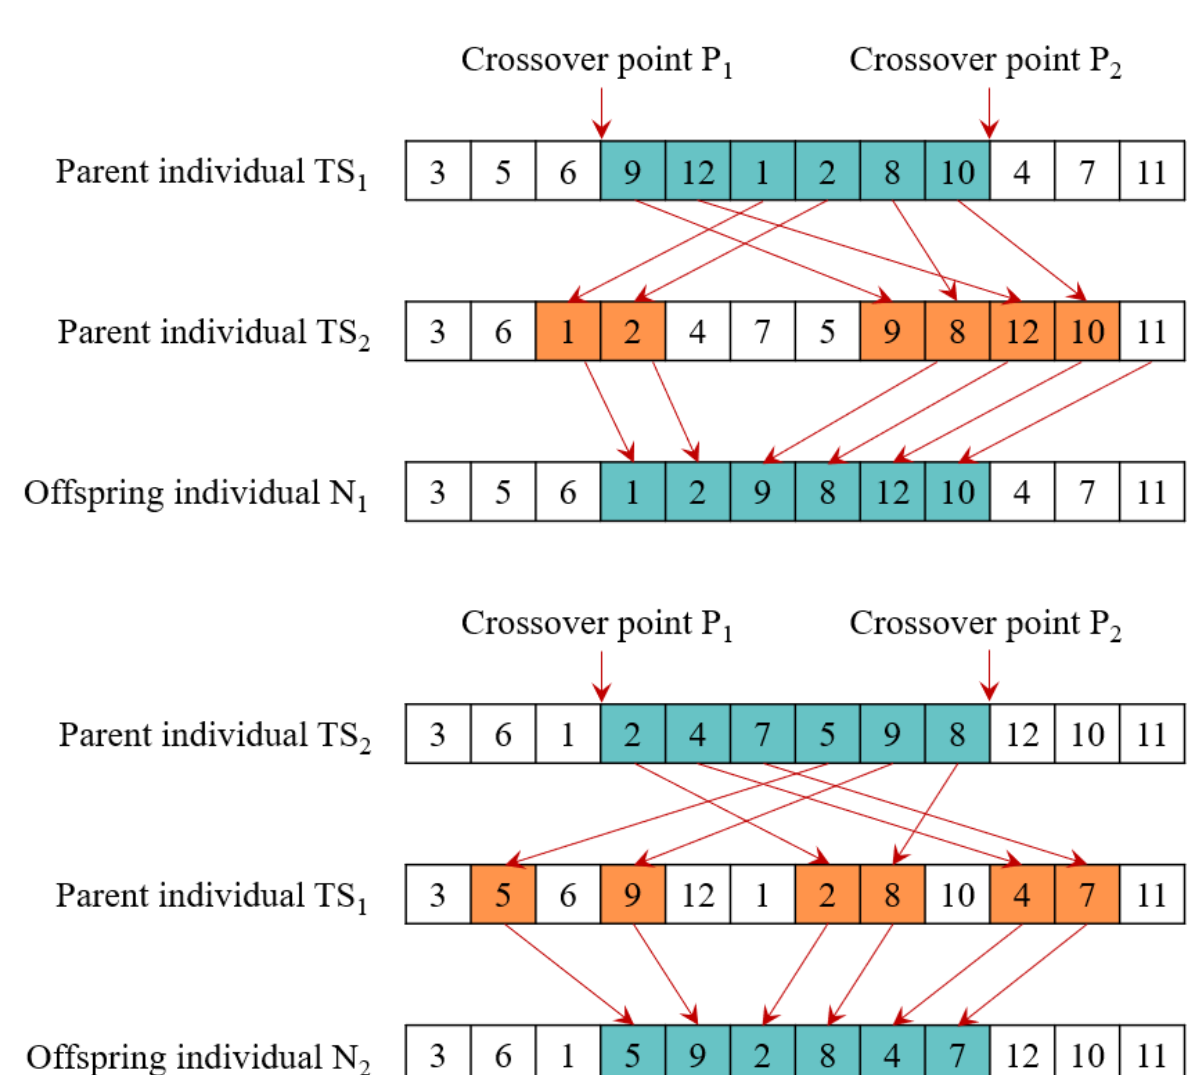
Figure 3. Individual crossover operation.